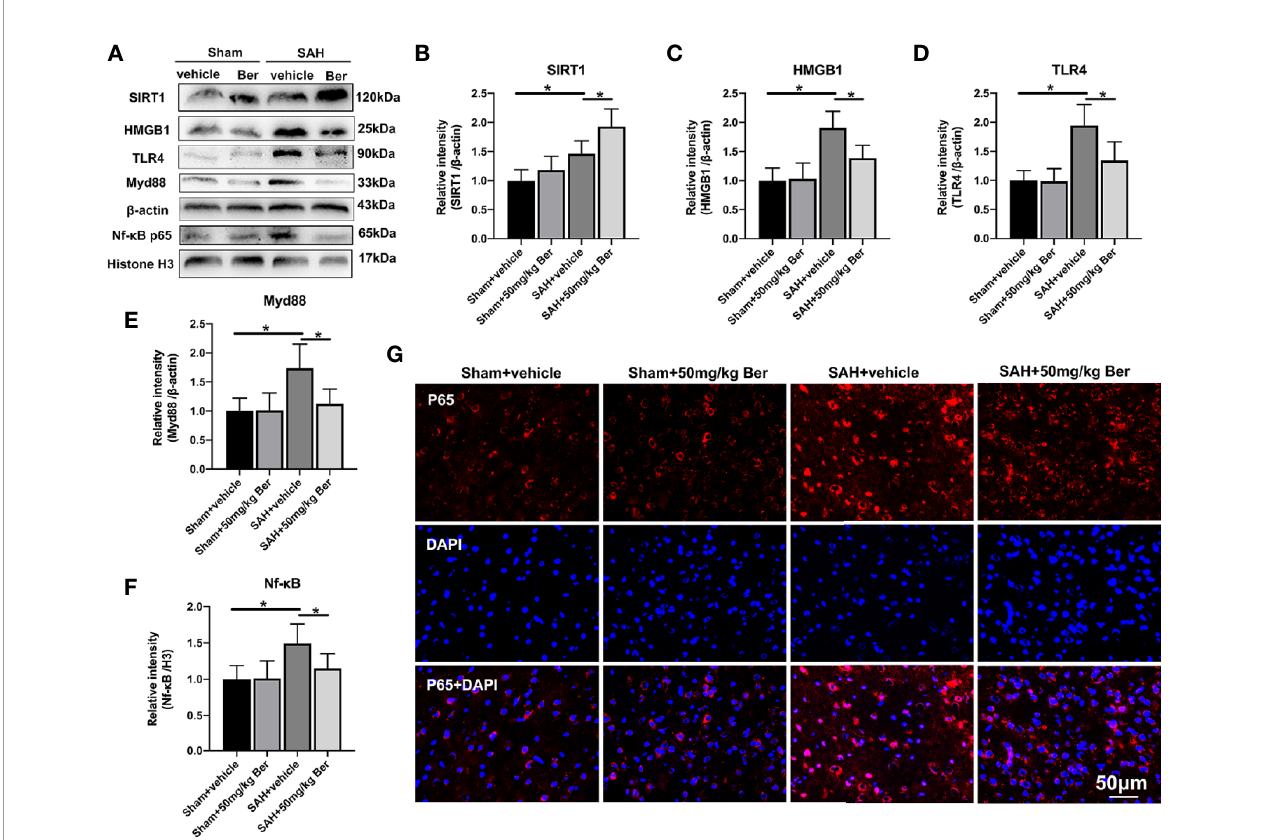
FIGURE 4 | Effects of berberine treatment on SIRT1/HMGB1/TLR4/Myd88/Nf- k B signaling pathway after SAH. (A – F) Western blot assay (A) and quanti fi cation for the expression of SIRT1 (B) , HMGB1 (C), TLR4 (D) , Myd88 (E) , and Nf- k B p65 (F) in the indicated groups. n = 6 per group. (G) Representative photomicrographs of immuno fl uorescence staining for Nf- k B p65. Bars represent the mean ± SD. * P <